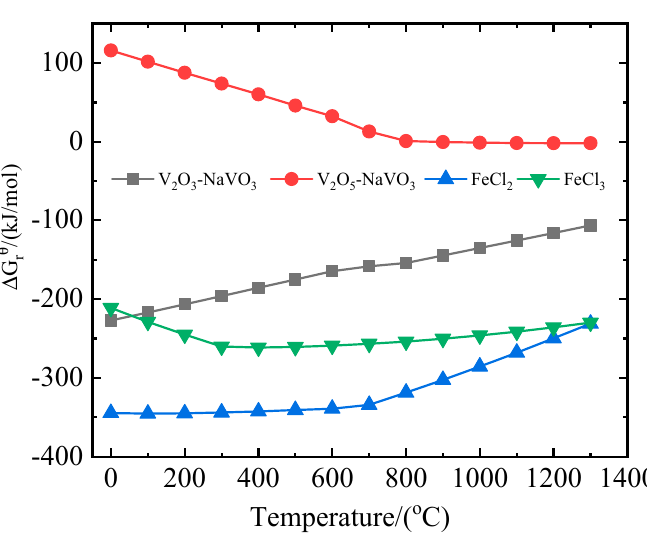
Figure 4. Variation of standard Gibbs free energy of reactions 23–26 with temperature.